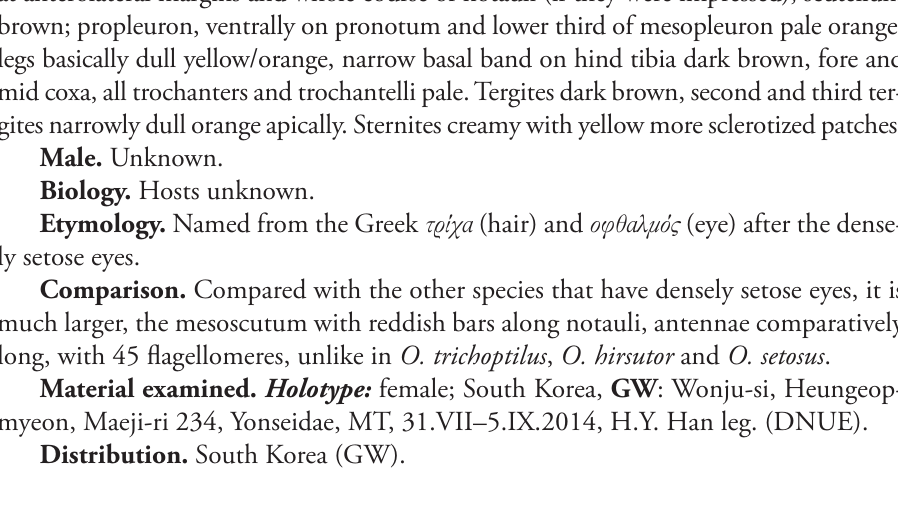
Description. Female. Fore wing length 2.6